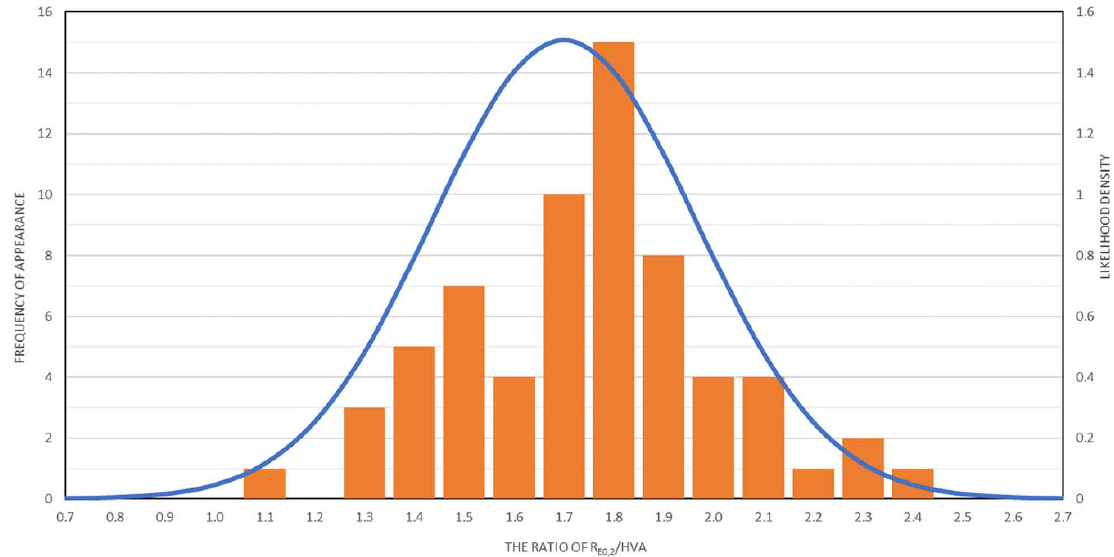
Figure 12. The relationship between the microhardness values and the conventional yield strength Re 0.2 depending on the joining method used. Re 0.2 depending on the joining method